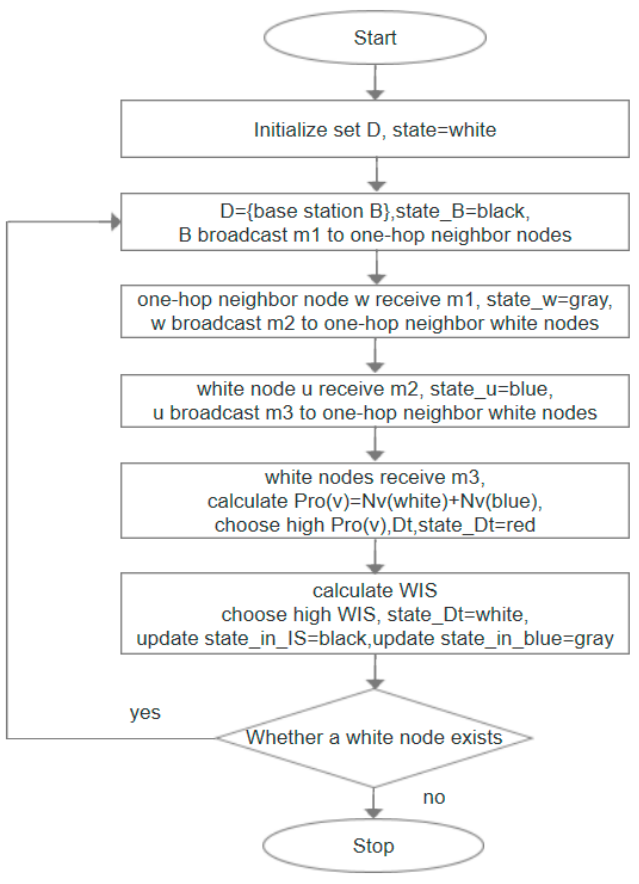
Figure 4. Flowchart of IC-MIS algorithm. The node that receives the broadcast message continues to broadcast the message to its one-hop neighbors.